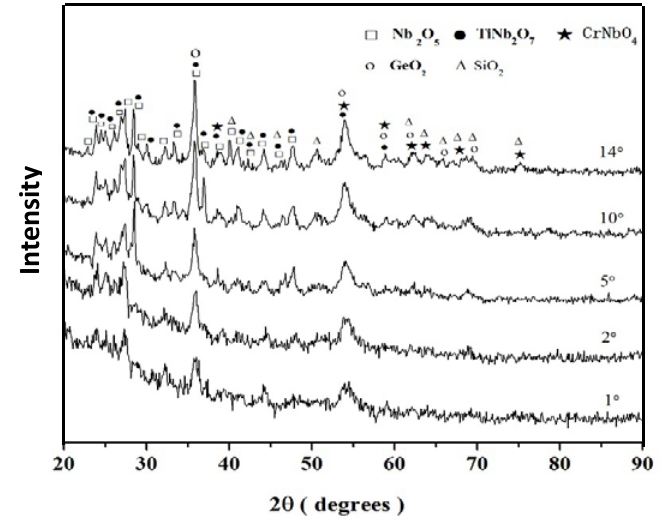
Figure 3. The di ff raction peaks of the Nb 2 O 5 and TiNb 2 O 7 oxides were present in the di ff ractograms Figure 3. The diffraction peaks of the Nb 2 O 5 and TiNb 2 O 7 oxides were present in the diffractograms taken at all glancing angles. Most di ff raction peaks of the oxides SiO 2 , GeO 2 , and CrNbO 4 were taken at all glancing angles. Most diffraction peaks of the oxides SiO 2 , GeO 2 , and CrNbO 4 were ◦ ◦ observed from γ ≥ 5 . At γ = 14 most of the peaks corresponded to the oxides Nb 2 O 5 and TiNb 2 O 7 , observed from γ ≥ 5°. At γ = 14° most of the peaks corresponded to the oxides Nb 2 O 5 and TiNb 2 O 7 , ◦ there was only one independent peak for SiO 2 (2 θ = 50.6 ), and no independent peak corresponding to there was only one independent peak for SiO 2 (2θ = 50.6 °), and no independent peak corresponding the GeO 2 and CrNbO 4 oxides. to the GeO 2 and CrNbO 4 oxides.